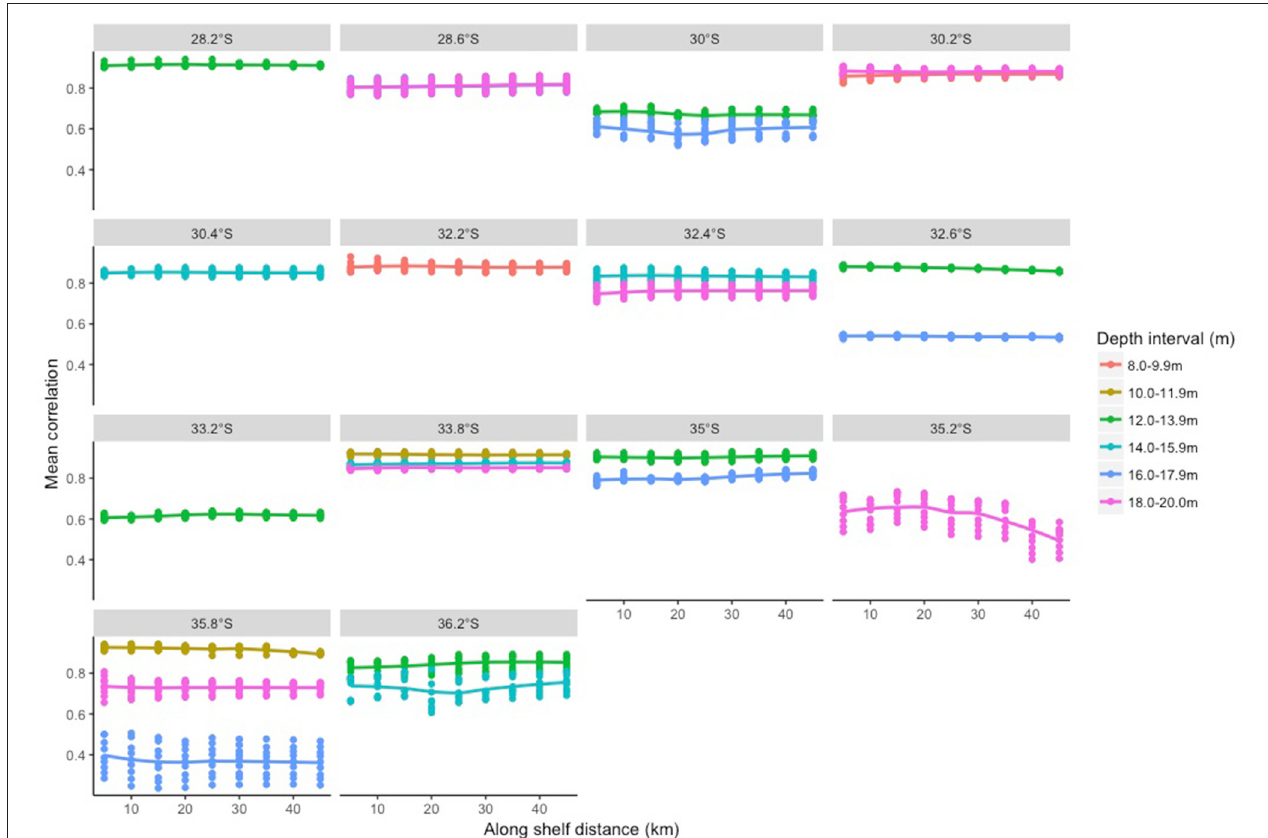
FIGURE 6 | Mean Pearson’s correlation between satellite data and in situ data for different along-shelf distances.